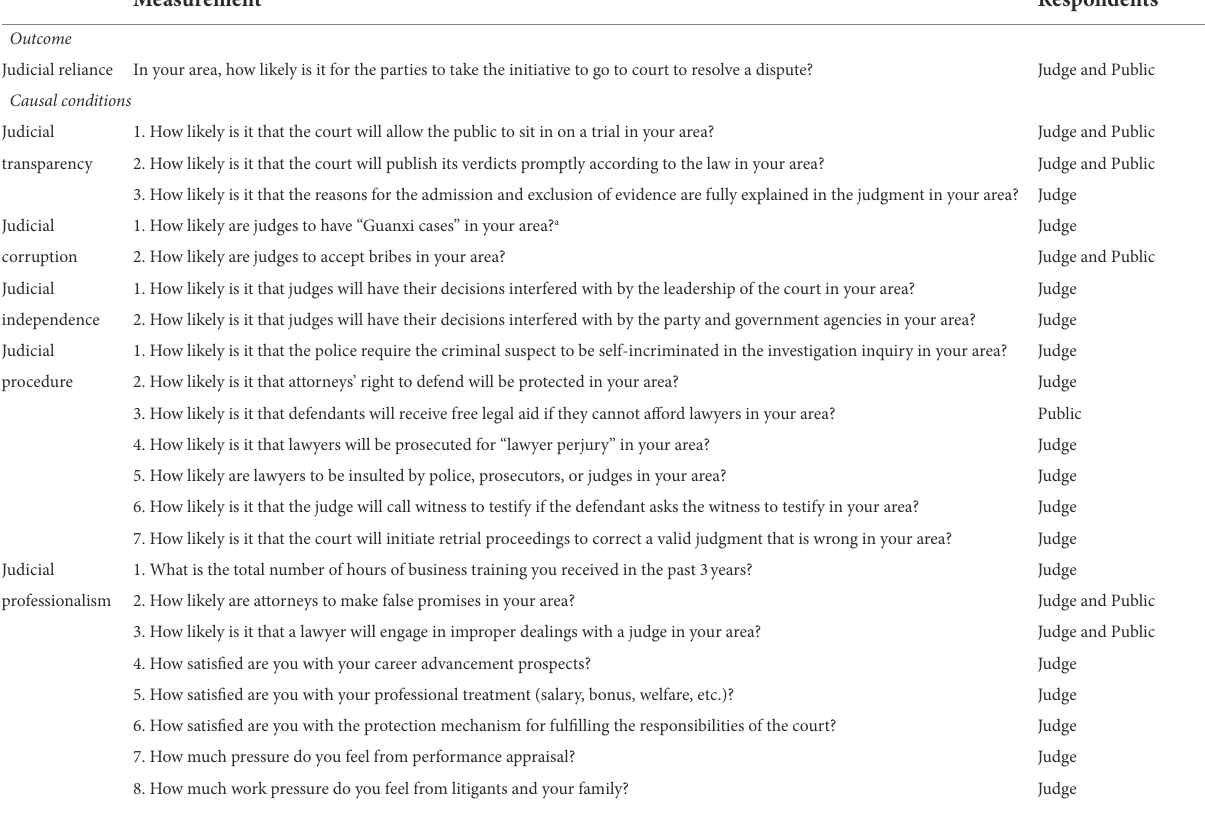
TABLE 1 Outcome, causal conditions, and